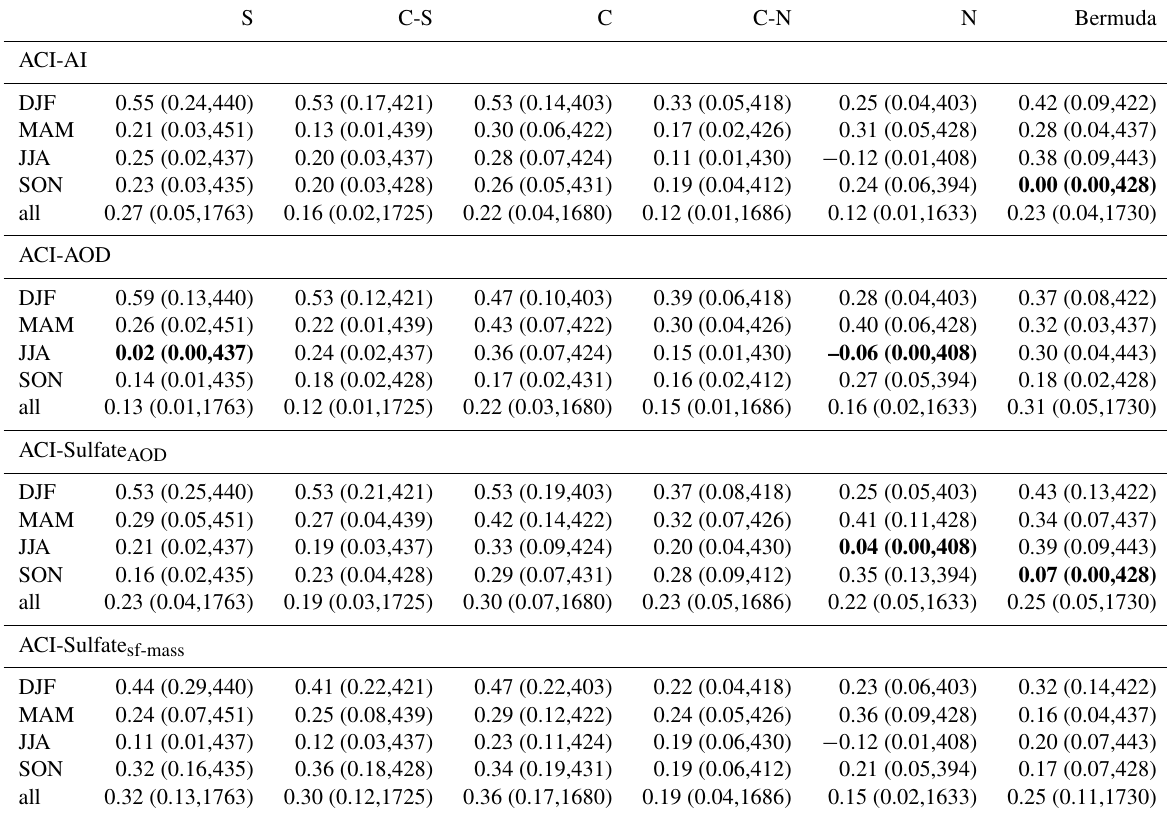
Table 4. Estimated values of ACI calculated four ways (dlog (N d )/ dlog ( AOD ) ; dlog (N d )/ dlog ( AI ) ; dlog (N d )/ dlog ( Sulfate AOD ) ; dlog (N d )/ dlog ( Sulfate sf-mass ) ) for the sub-domains shown in Fig. 2. The ACI values were obtained from log–log regression on average daily values of N d and each of the aerosol proxy variables including only the pixels with CF low-liq. greater than 0.1. Numbers in parentheses, in order, are R 2 and the number of points used for linear regression. Statistically insignificant ACI values with p values greater than 0.05 are marked by bold